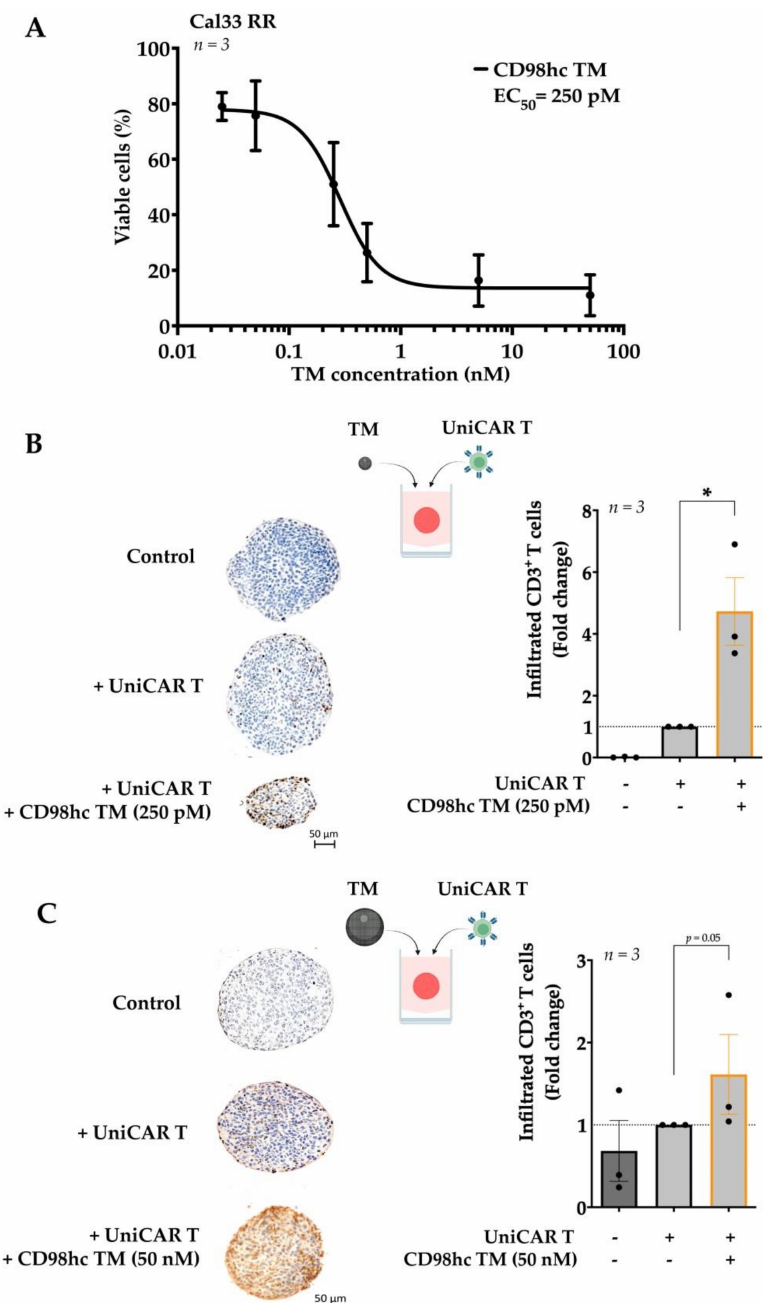
Figure 3. Different CD98hc TM concentrations increase UniCAR T cell infiltration into the tumor spheroids. ( A ) UniCAR T cells were cocultured with Cal33 RR spheroids in the presence of differ- ent CD98hc TM concentrations (E:T = 5:1). Half-maximal effective concentration (EC 50 ) value was calculated relative to untreated control based on the obtained dose-response curves. ( B ) Immunohisto- chemical analyses of the median sections of spheroids showed increased infiltration levels of UniCAR T cells in the presence of CD98hc TM at a concentration of 250 pM. Infiltrated CD3 + T cells (brown spots) were counted blindly by three independent investigators. ( C ) Immunohistochemical analyses of the median sections of spheroids showing increased infiltration levels of UniCAR T cells in the presence of CD98hc TM at a concentration of 50 nM. Infiltrated CD3 + T cells were counted blindly by three independent investigators. Scale bar: 50 µ m. Experiments were performed in triplicates. Paired t -test was applied to calculate the statistical significance of the infiltration rate (treated vs. control spheroids); error bars, mean ± SEM. * p <